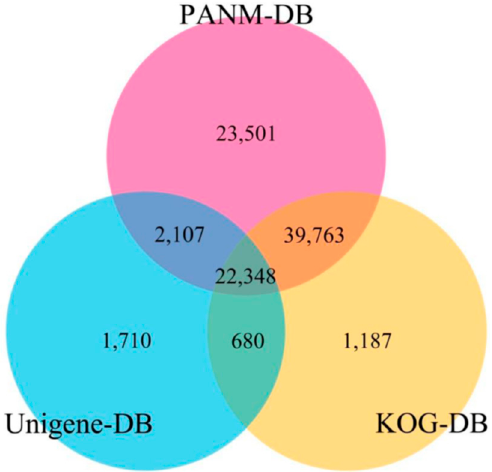
Figure 2. The sequence annotation profile of T. longicaudatus unigenes against PANM-DB, Unigene DB and KOG DB.